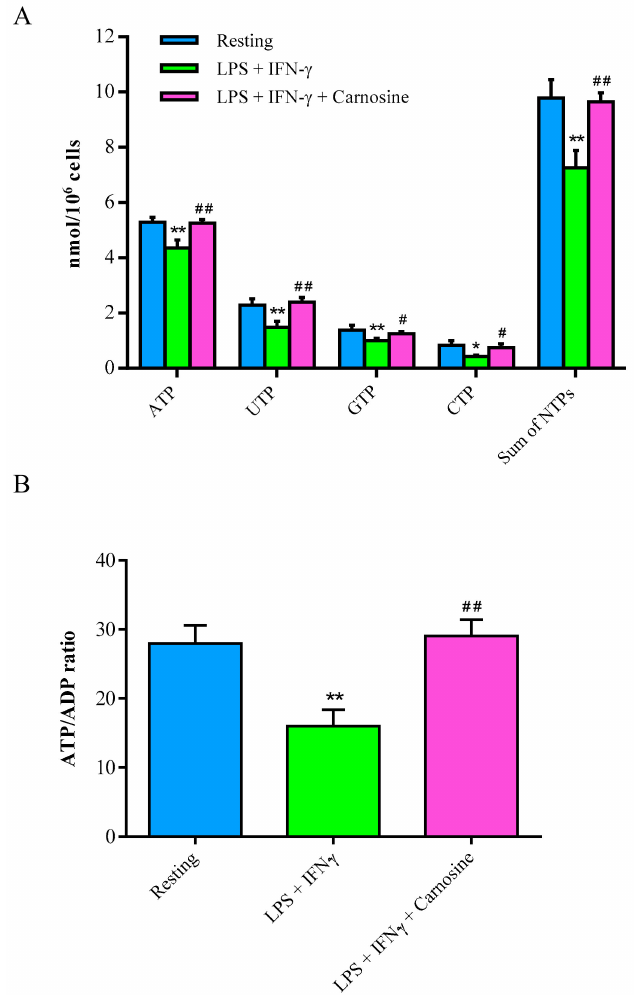
Figure 3. ( A ) Changes in nucleoside triphosphate concentrations (ATP, GTP, UTP, CTP and sum of nucleoside triphosphates), expressed as nmol / million cells, and ( B ) ATP / ADP ratio in resting (control) RAW 264.7 macrophages and in macrophages stimulated with LPS (100 ng / mL) + IFN- γ (600 U / mL), in the absence or in the presence of carnosine (20 mM). NTPs = nucleoside triphosphates. Values are means ± SD of three to four independent experiments. * p < 0.05 vs. resting; ** p < 0.01 vs. resting; # p < 0.05 vs. LPS + IFN- γ ; ## p < 0.01 vs. LPS + IFN- γ